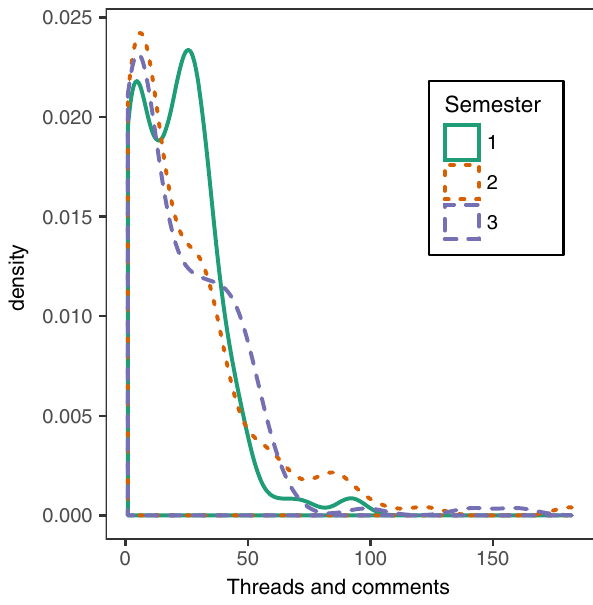
FIG. 3. Density distribution of forum activity (combined threads and comments) for class members by semester. The instructor ’ s contribution totals are included and are 94, 182, and 141 by